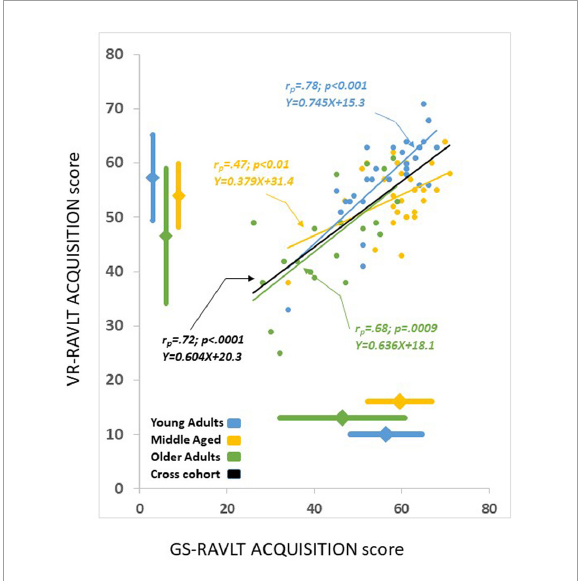
FIGURE2 A visual depiction of the correlations between the gold standard-Rey Auditory Verbal Learning Test (GS-RAVLT) and the virtual reality adaptation of the Rey Auditory Verbal Learning Test (VR-RAVLT) acquisition scores, overall and within the young adults (YA), the middle aged (MA), and the older-adults (OLD) groups. Solid lines indicate linear fits. Diamonds and thick lines adjacent to the axes indicate averages and standard deviations. The correlations between the age groups ranged from 0.47 to 0.78; all correlations were significant. In order to determine whether the slopes of the regressions between the groups were homogeneous, we performed a univariate test and we found non-significant results F ( 2 , 72 ) = 49.8, p = 0.68 indicating that the slopes are not significantly different.